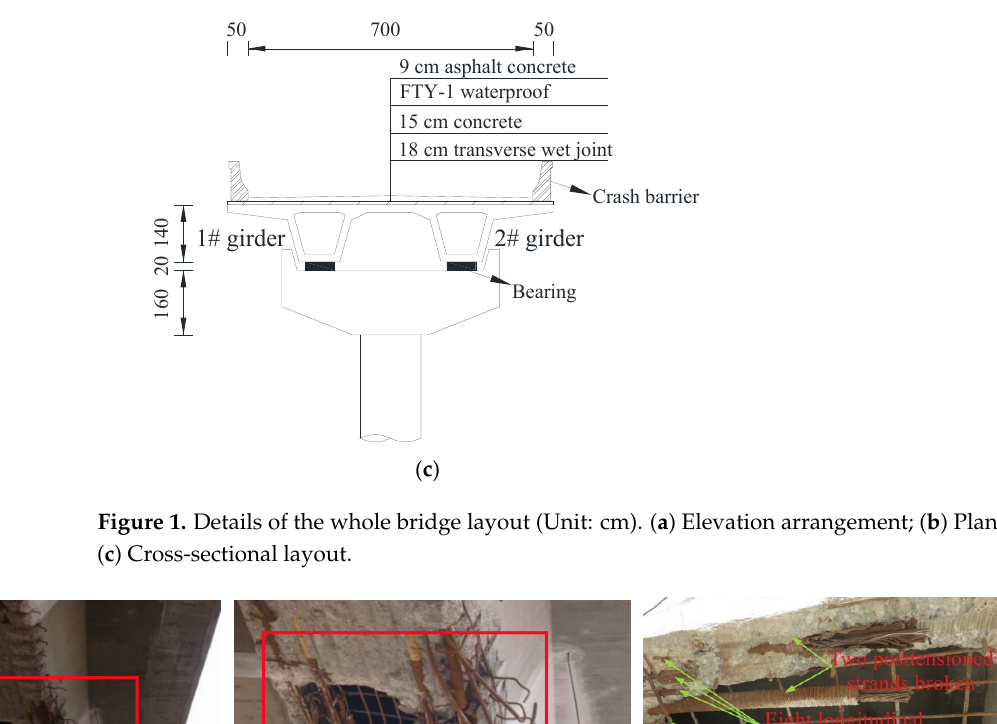
slight abrasion in the local position.